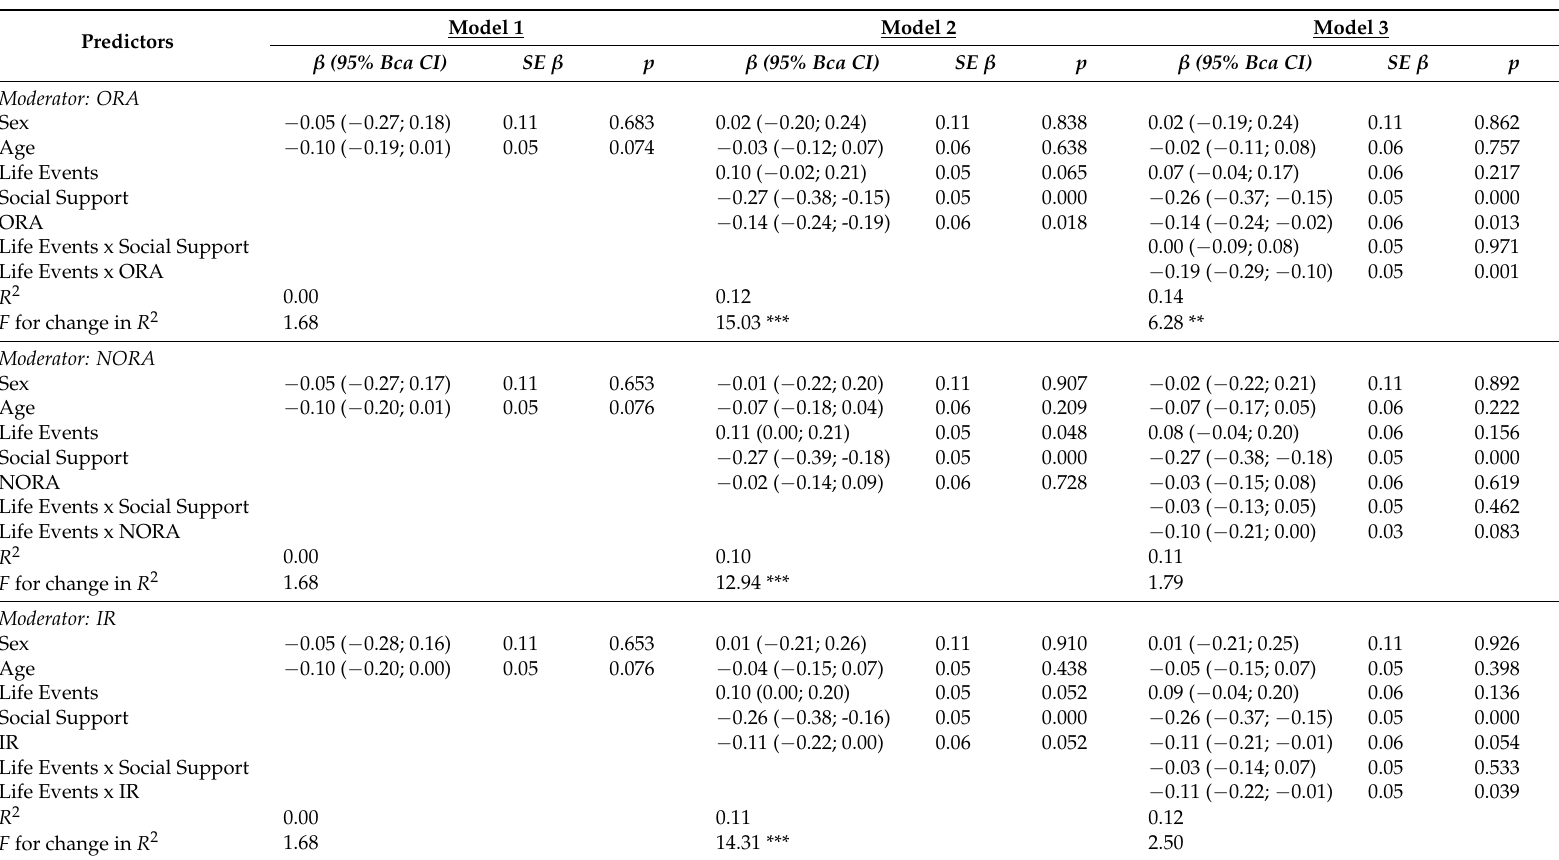
Table 2. Hierarchical linear regression for depressive symptoms—divided by ORA, NORA, IR (standardized coefficients; n = 348). Model 1 Model 2 Model Predictors